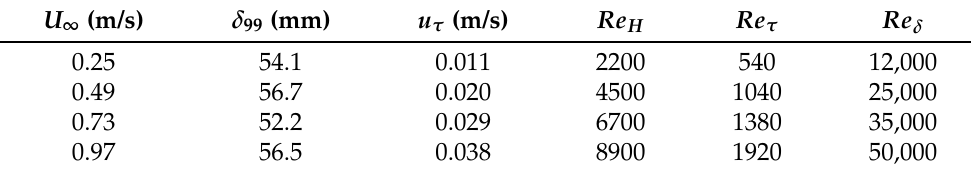
Table 1. Characteristics of the incoming flow for each free-stream condition.